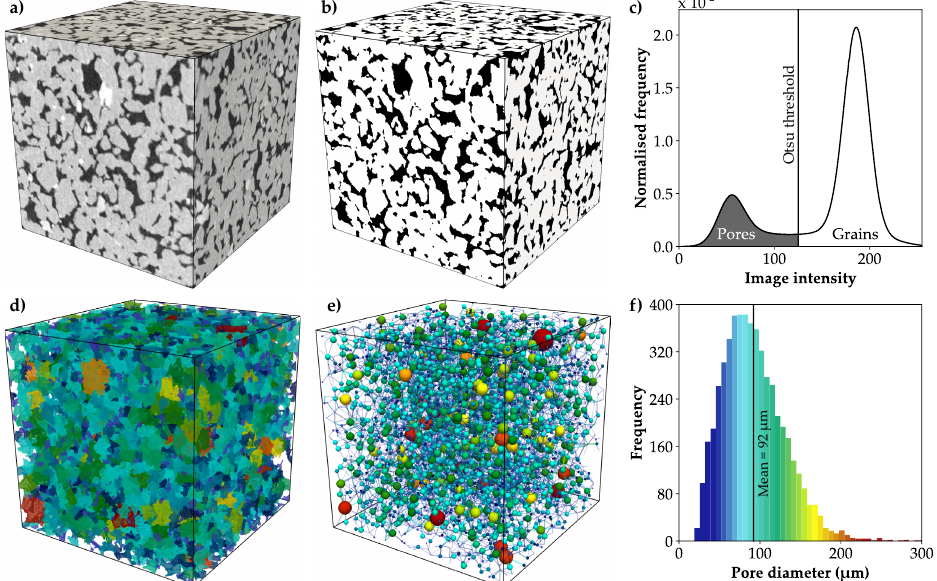
Figure 2. ( a ) Micro-CT scan of the Bentheim sandstone with a size of 500 3 voxels and a resolution of 4.9 µ m. ( b ) The 3D image is binarised by ( c ) an intensity-based separation of the pore space and grains using the Otsu threshold [49]. ( d ) The entire pore space is partitioned into individual pores (coloured by diameter) and ( e ) the pore network is extracted. ( f ) Pore size distribution with a mean diameter of 92 µ